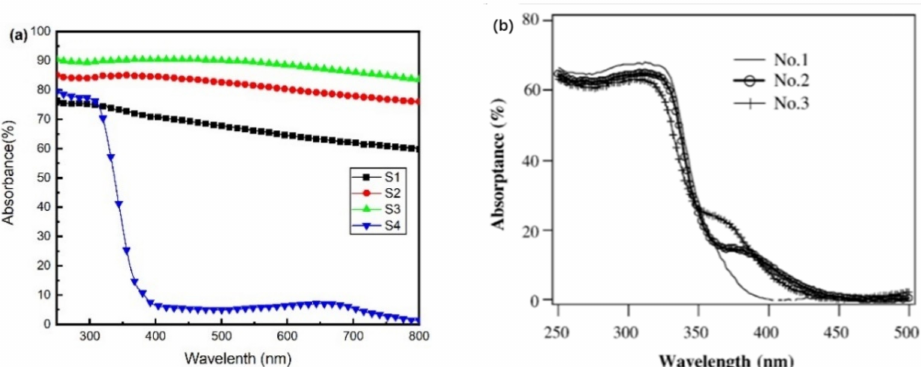
Figure 4. ( a ) The ultraviolet-visible absorbance of Samples S1, S2, S3, and S4; ( b ) the absorbance of films treated by H 2 or N 2 , No.1: untreated TiO 2 , No.2: TiO 2 treated by H 2 , No.3: TiO 2 treated by N 2